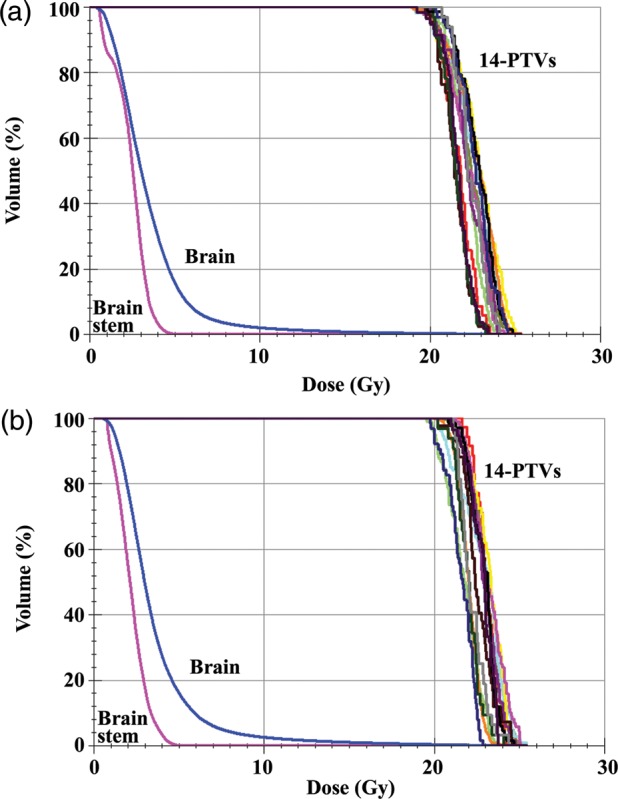
Dose–volume histograms. A D95 dose of 20 Gy in a single fraction was prescribed for (a) each of the 14 PTVs and (b) the entire volumes of the 14 PTVs. Dose restrictions were applied to normal brain, including the brain stem outside the targets.